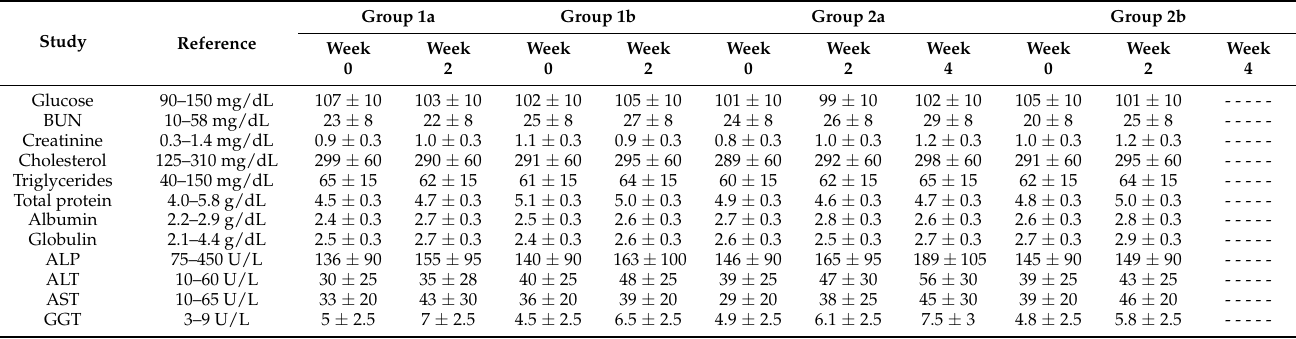
Table 3. Blood chemistry values of dogs during treatment with AgNPs and supportive